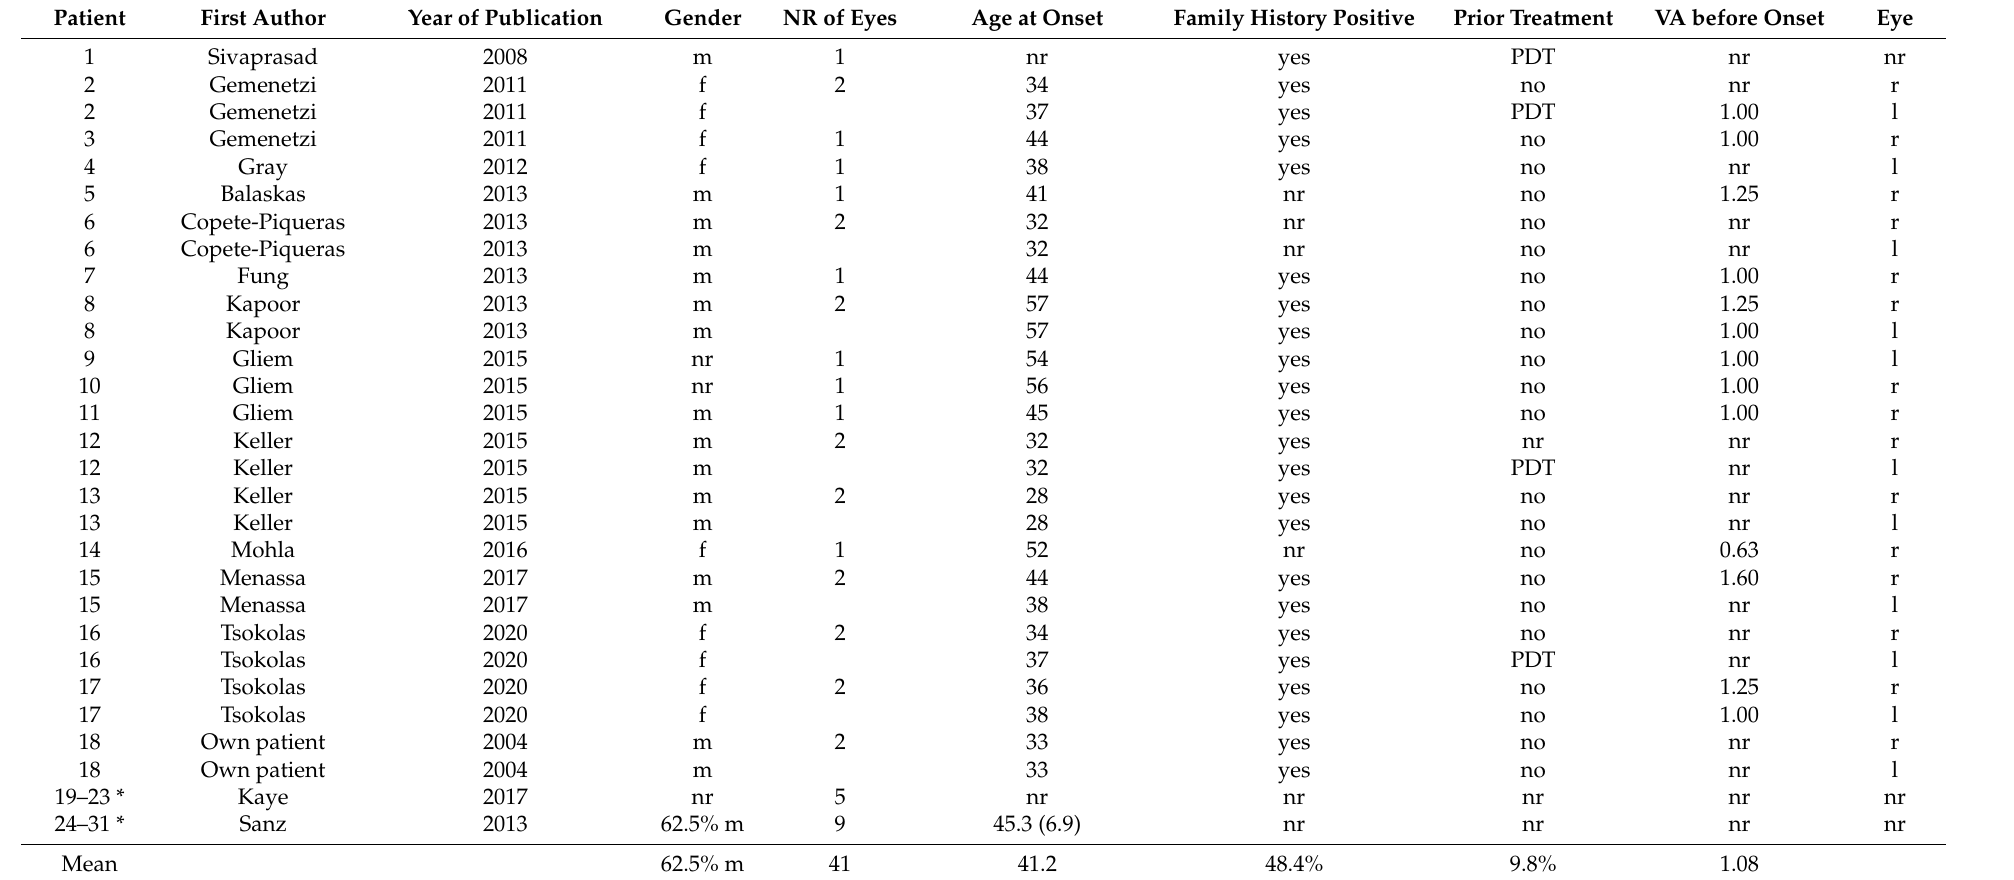
Table 1. Treatment outcomes of case and cohort studies with Sorsby’s fundus dystrophy, part